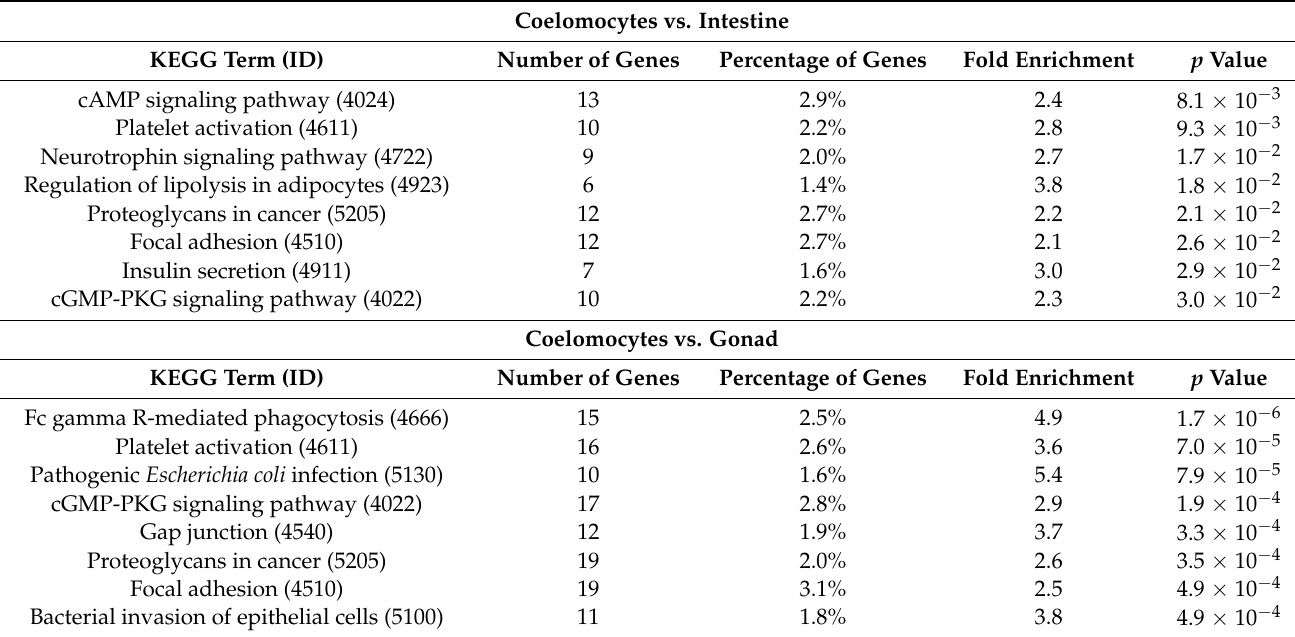
Table 2. The Top-16 KEGG pathways enrichment of up-regulated transcripts of coelomocytes in the edible red sea urchin ( L. albus ). In comparison to intestine, cAMP signaling pathway was the most overrepresented and Fc gamma R-mediated phagocytosis compared to gonad.